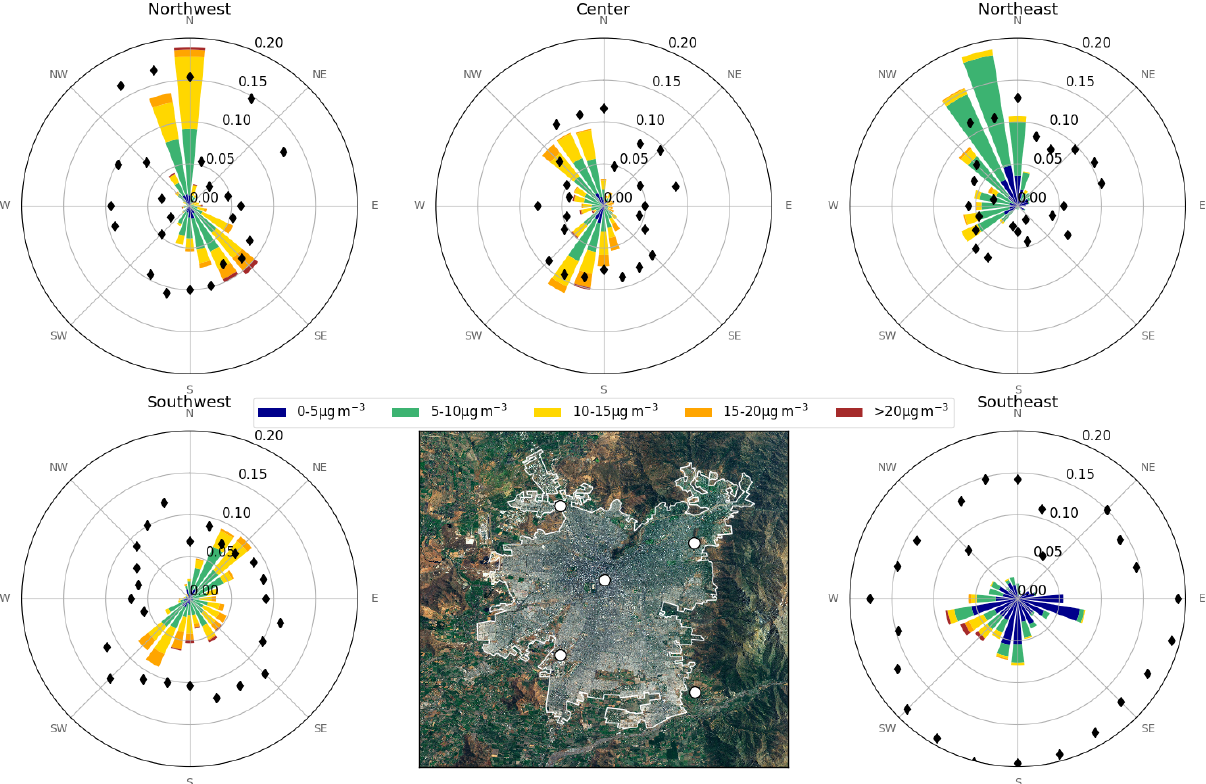
Figure 7. Joint distribution of hourly wind direction (length of the bar gives the frequency of the corresponding wind direction) and PM 2 . 5 concentration (color map) in scenario WC for five locations in Santiago. Black diamonds show the maximum relative contribution of transport (i.e., WC or WB) for each wind direction bin (note – the scale is the wind frequency scale multiplied by 5; i.e., 0.20 is actually 1.0). The bottom center map shows the location of the considered grid points. Map background layer source: Imagery World 2D, © 2009